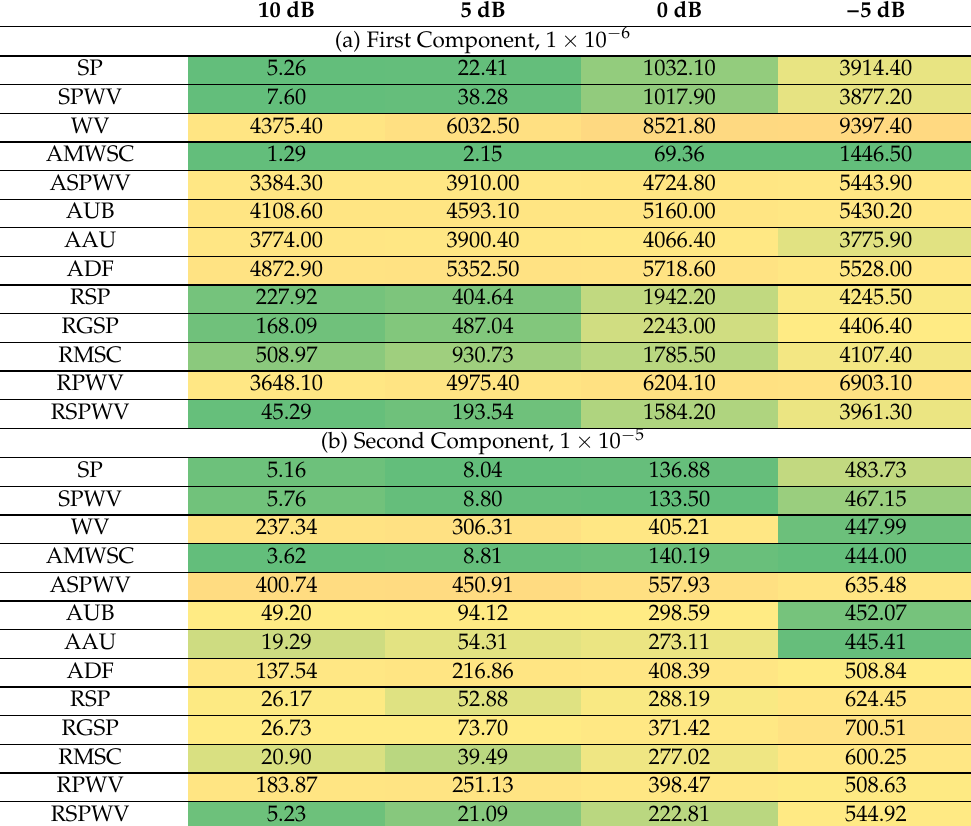
Table 7. Estimation of IF MSE for a noisy multi-component signal with concurrent constant and parabolic FM components for different SNR levels (averaged over 100 noise realizations), cell colors range from green for the best result to red for the worst result in each column